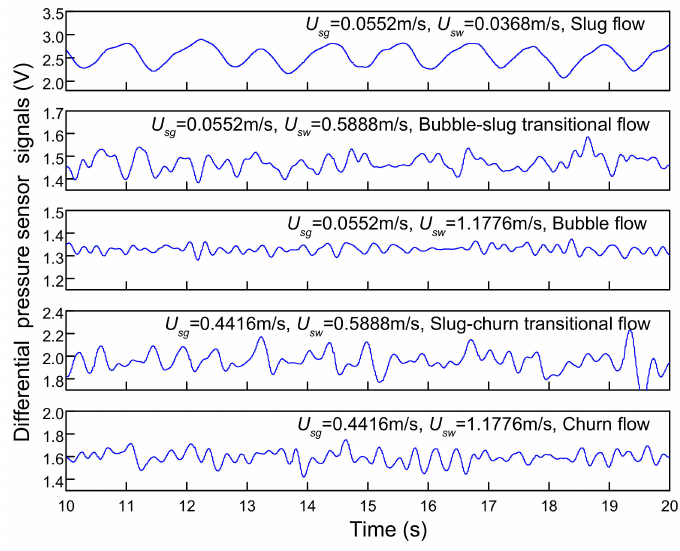
Figure 6. The responses of di ff erential pressure sensor.